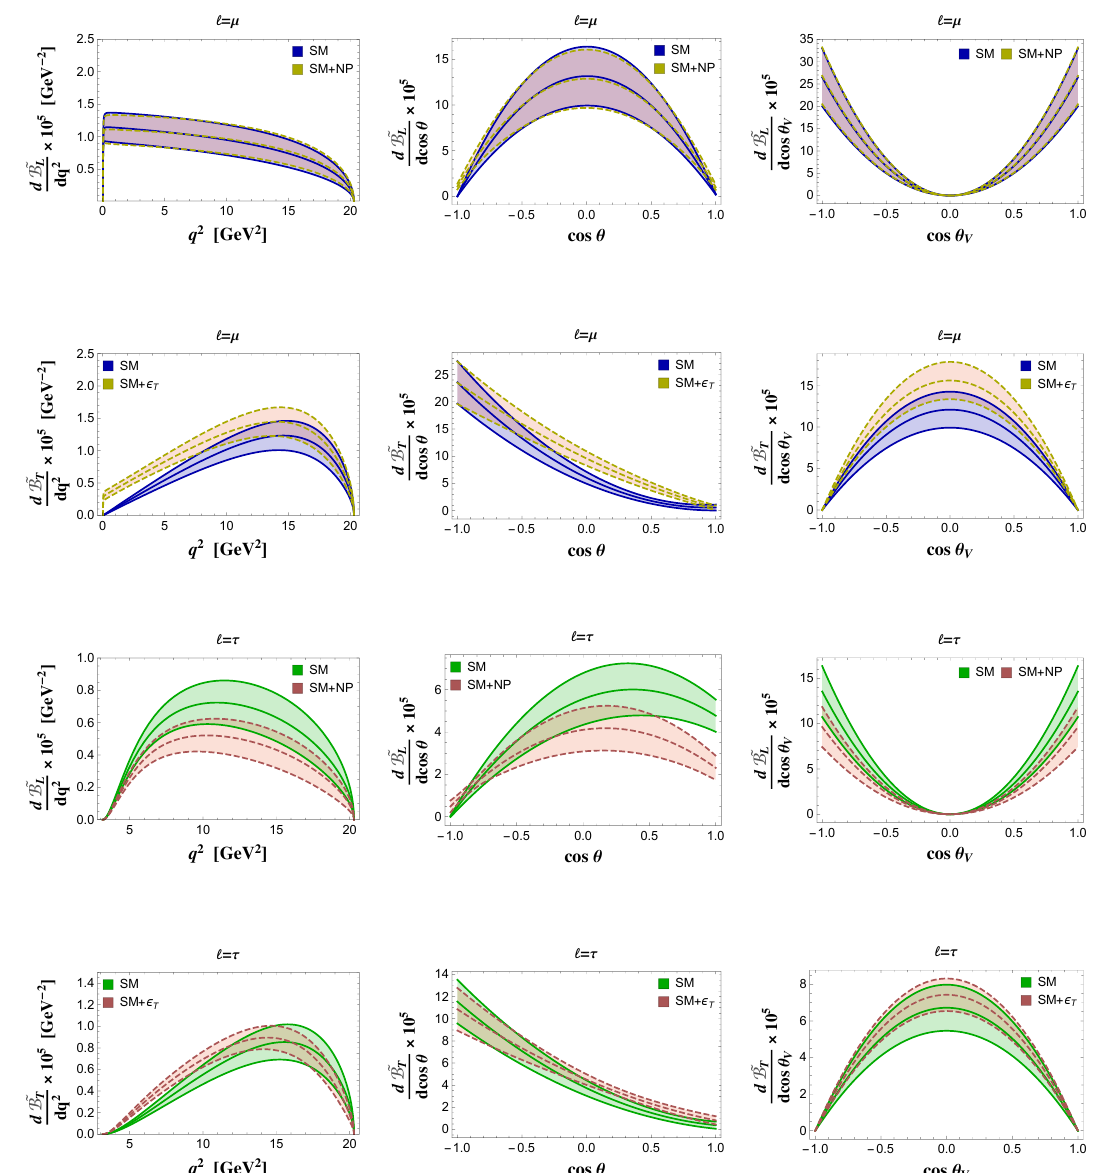
Figure 12. ¯ B → ρ µ − ¯ ν µ mode: distributions d ˜ B L / dq 2 , d ˜ B L / d cos θ and d ˜ B L / d cos θ V (plots in the first row) and d ˜ B T / dq 2 , d ˜ B T / d cos θ and d ˜ B T / d cos θ V (plots in the second row), with ˜ B = B / B ( ρ → ππ ) for SM and NP. The plots in the third and fourth row are the analogous distributions for ¯ B → ρ τ − ¯ ν τ